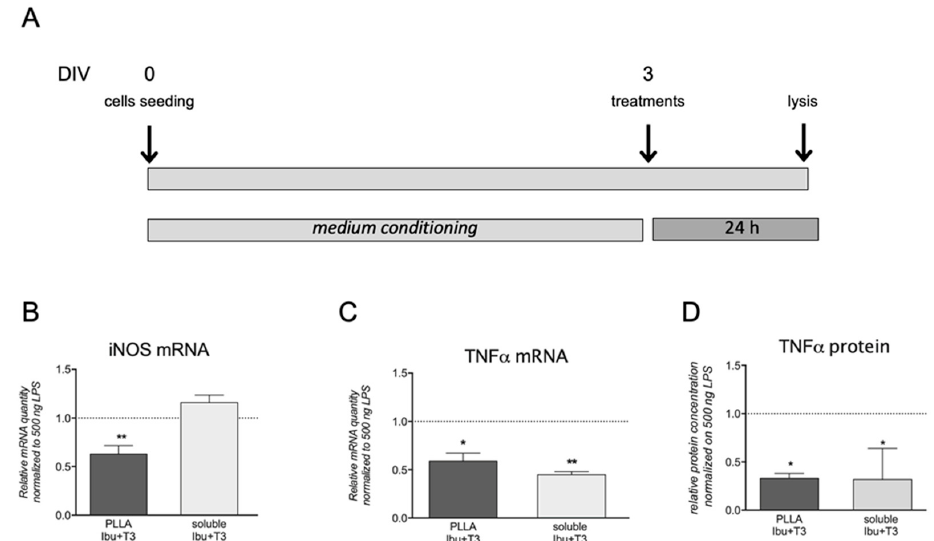
Figure 6. Effect of the PLLA+Ibu+T3 conditioned medium on LPS-induced molecular regulations in macrophages. ( A ) Schematic representation of the experiment timeline. ( B – D ) The graphs show the effect of ibuprofen and T3 derived by PLLA + IBU + T3-conditioned medium on the mRNA expression of iNOS ( B ) and TNF- α ( C ) genes, and TNF- α protein ( D ). The graphs report the expression levels expressed as variations (fold of change) with respect to LPS-PLLA exposed culture, indicated by the horizontal bar. Statistical analysis: Student’s t-test, * p < 0.05, ** p < 0.01.